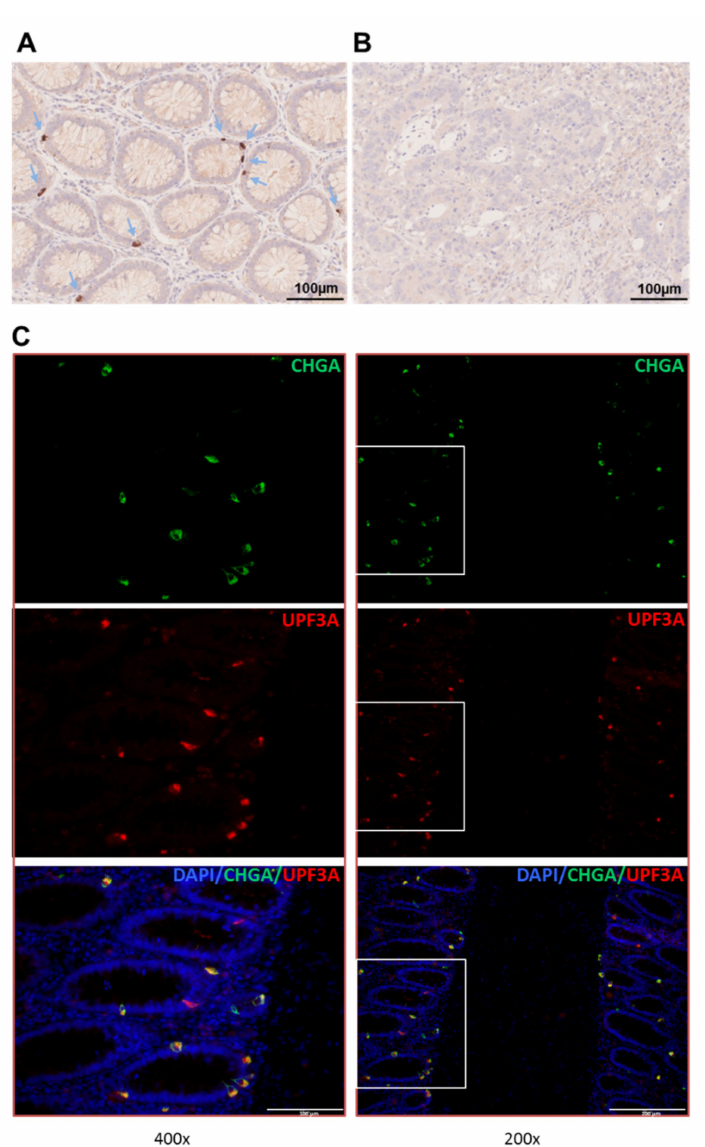
Figure 2. ( A , B ) Immunohistochemical staining of UPF3A in normal colon crypts ( A ) and MSI colorectal tumor( UPF3A mutated)( B ).Positivelystainedcellsareindicatedbyarrows. ( C )Doubleimmunofluorescence staining of chromogranin A (CHGA; green), a marker of endocrine cells as well as UPF3A (red) in normal colon crypts. Cell nuclei were counterstained with 4 (cid:48) ,6-diamidino-2-phenylindole (DAPI). Overlay of the fluorescence signals confirms colocalization of both proteins (yellow and orange) in individual cells.